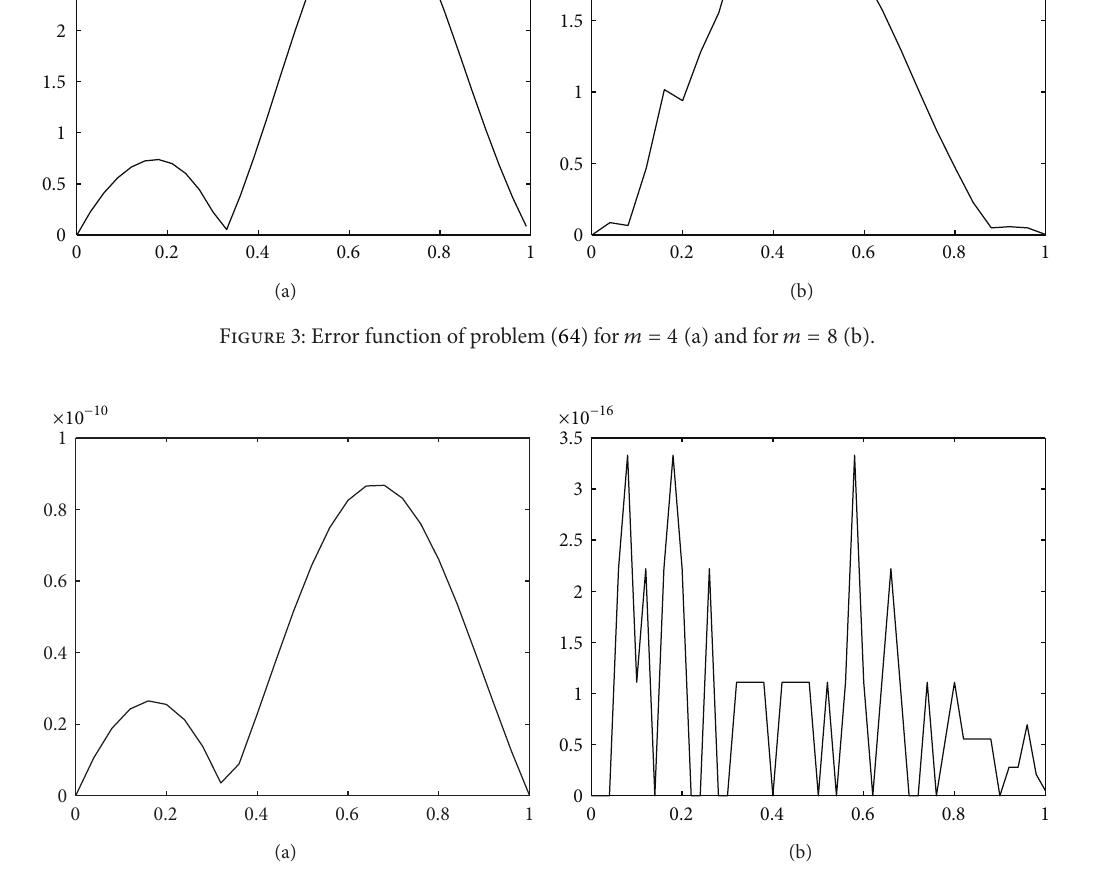
Figure 4: Error function of problem (65) for 𝑚 = 4 (a) and for 𝑚 = 8 (b).